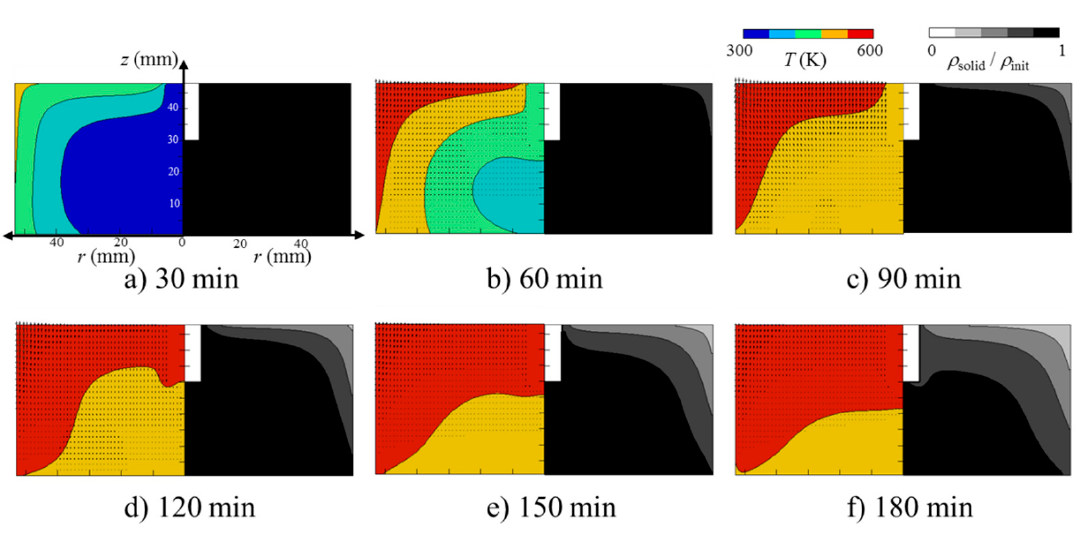
Figure 6. Calculation results for the time course of the temperature, velocity vectors, and total solid distribution during Douglas fir powder torrefaction. ρ init = 353 kg/m 3 .